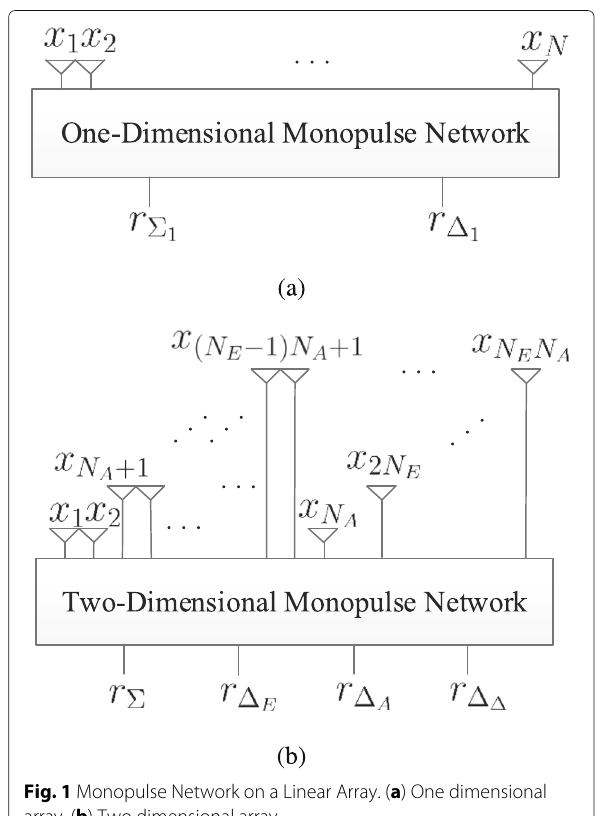
Fig. 1 Monopulse Network on a Linear Array. ( a ) One dimensional array, ( b ) Two dimensional